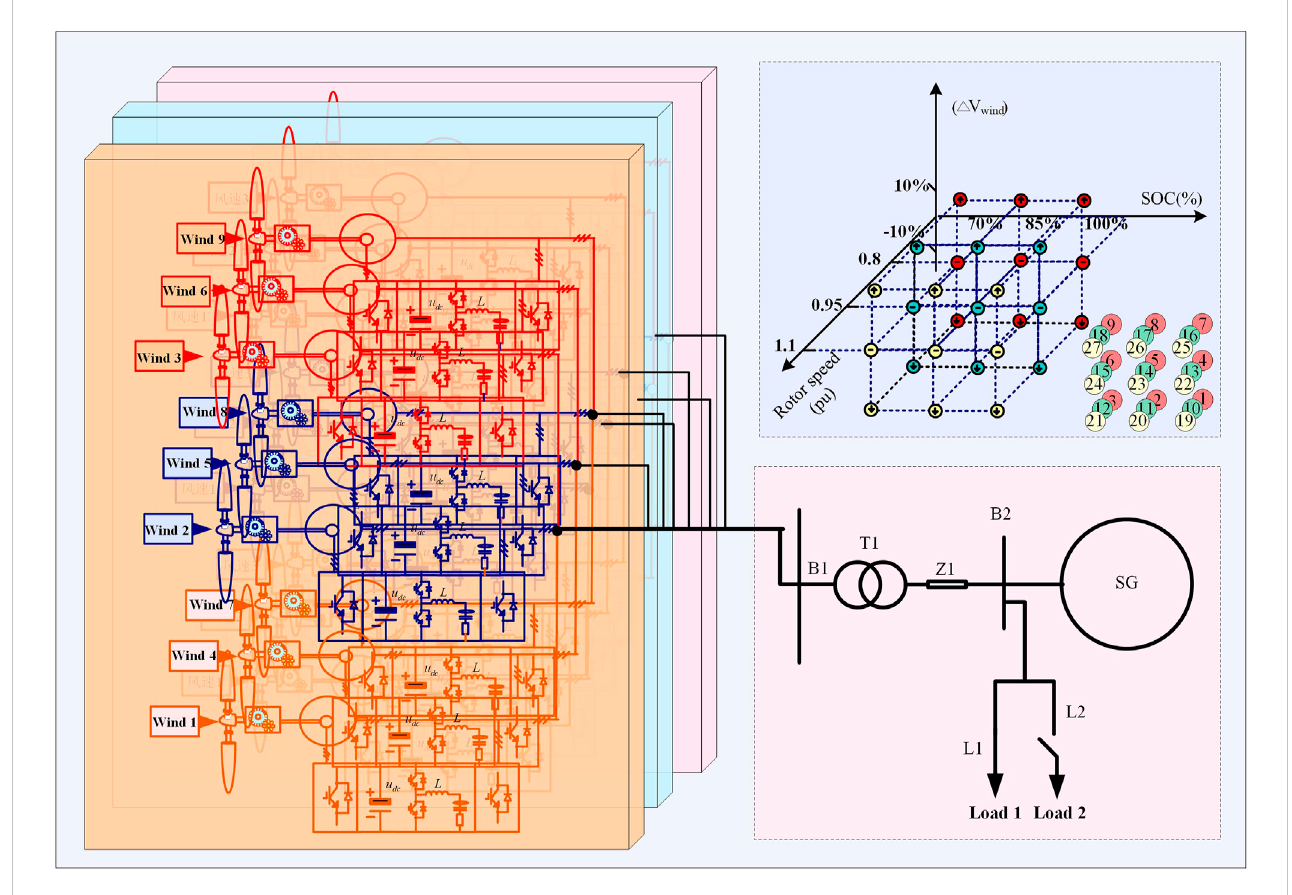
FIGURE 9 Three-dimensional simulation model architecture of SCESS-DFIG inertia response with variable wind speed.